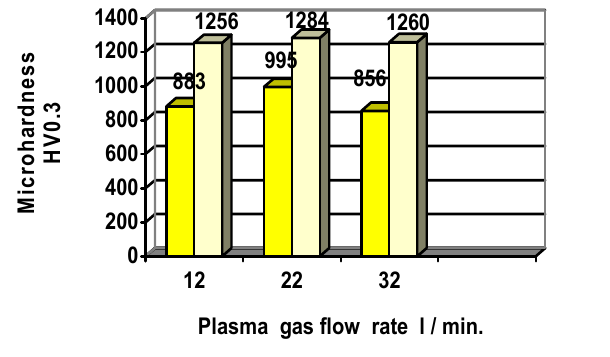
Figure 3 – Microhardness of WC17Co layers Slika 3 – Mikrotvrdo ć a WC17Co slojeva